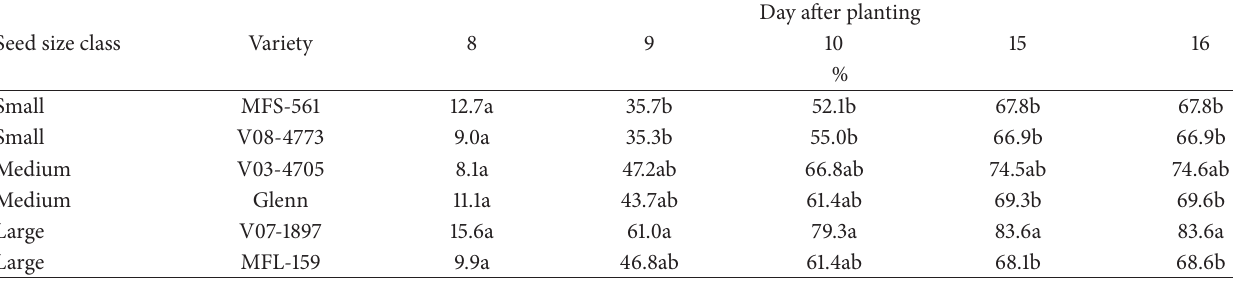
Table 5: Seedling emergence as a percentage of seeds planted in the field in 2013.